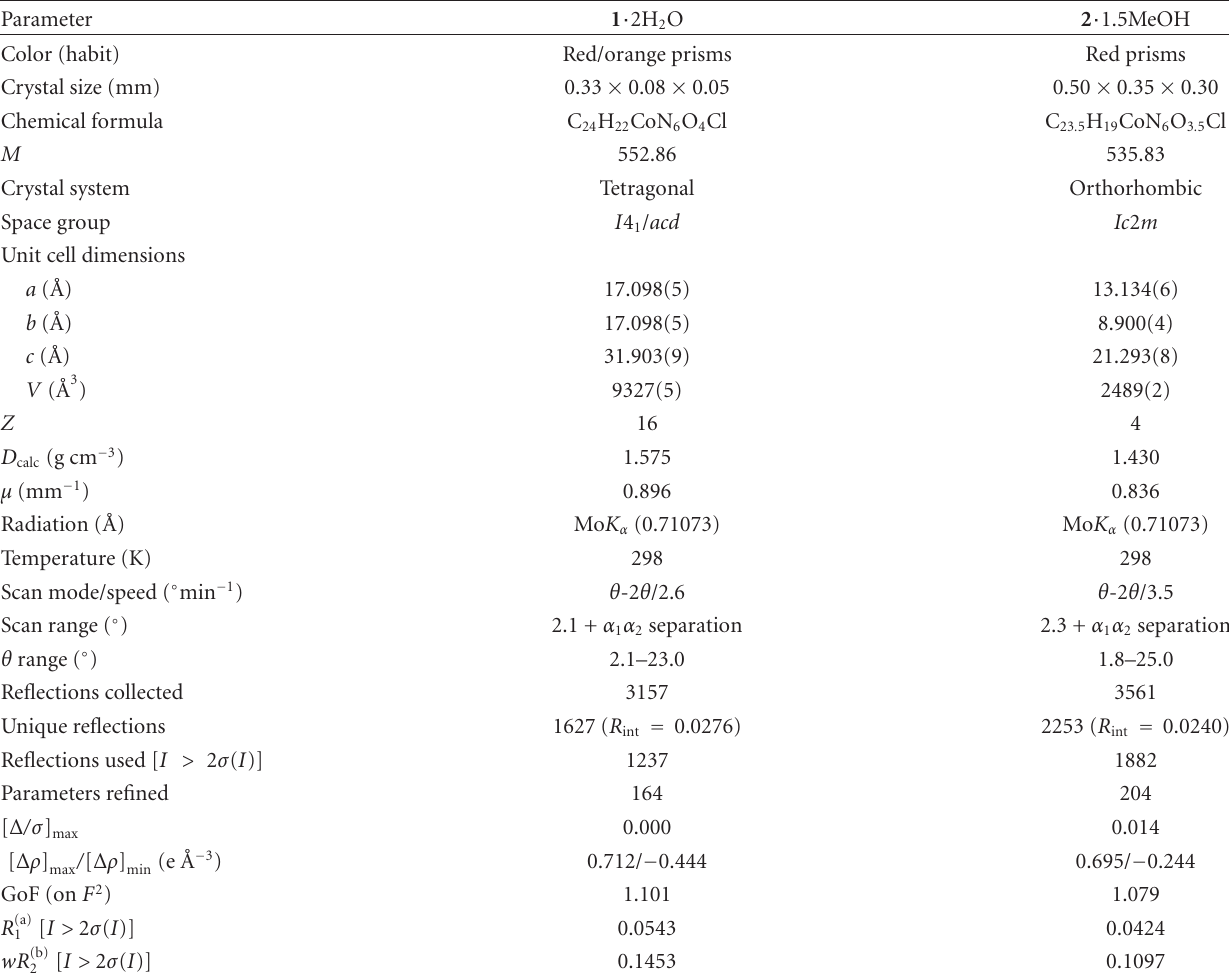
Table 1: Crystallographic data for complexes 1 · 2H 2 O and 2 ·